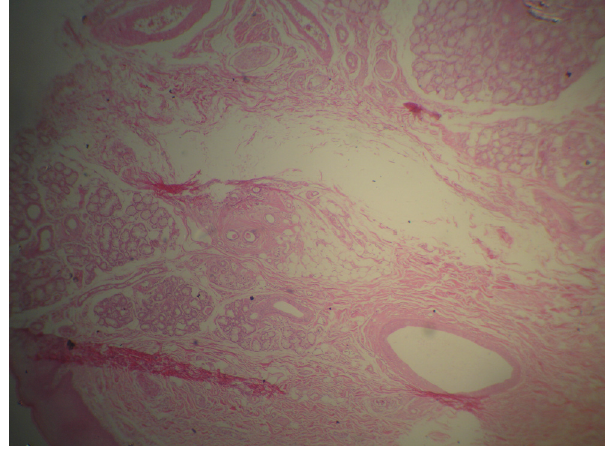
Figure 4 - Minor salivary glands hyperplasia